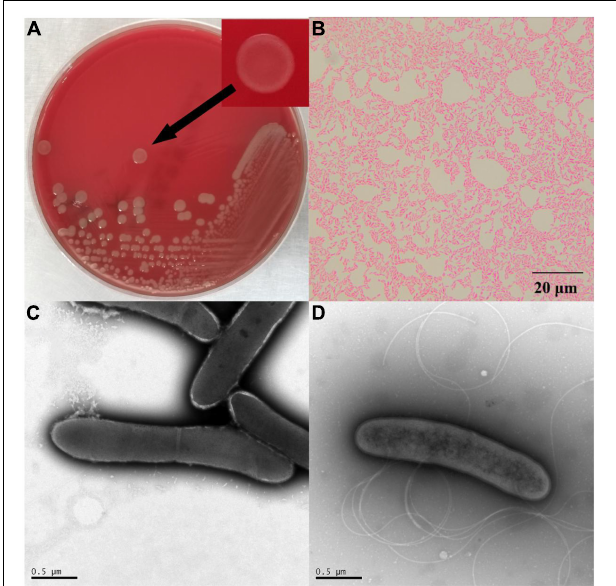
FIGURE 1 | The morphology of strain DYY3. (A) The cultured bacterial colonial morphology on blood agar plate of (cid:77) strain DYY3; (B) the Gram staining result shows that (cid:77) strain DYY3 is Gram weak positive; (C) the electron microscope photograph of the dividing cells of (cid:77) strain DYY3 after 24 h culture; (D) the electron microscope photograph shows the flagellum of (cid:77) strain